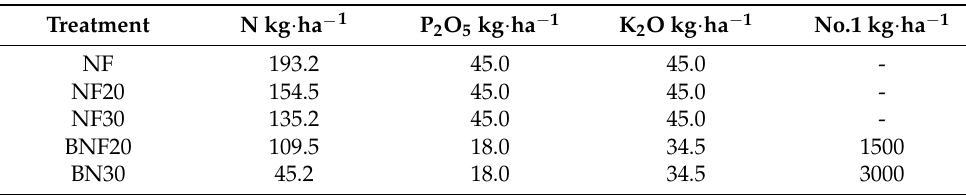
Table 1. Fertilization situation in test